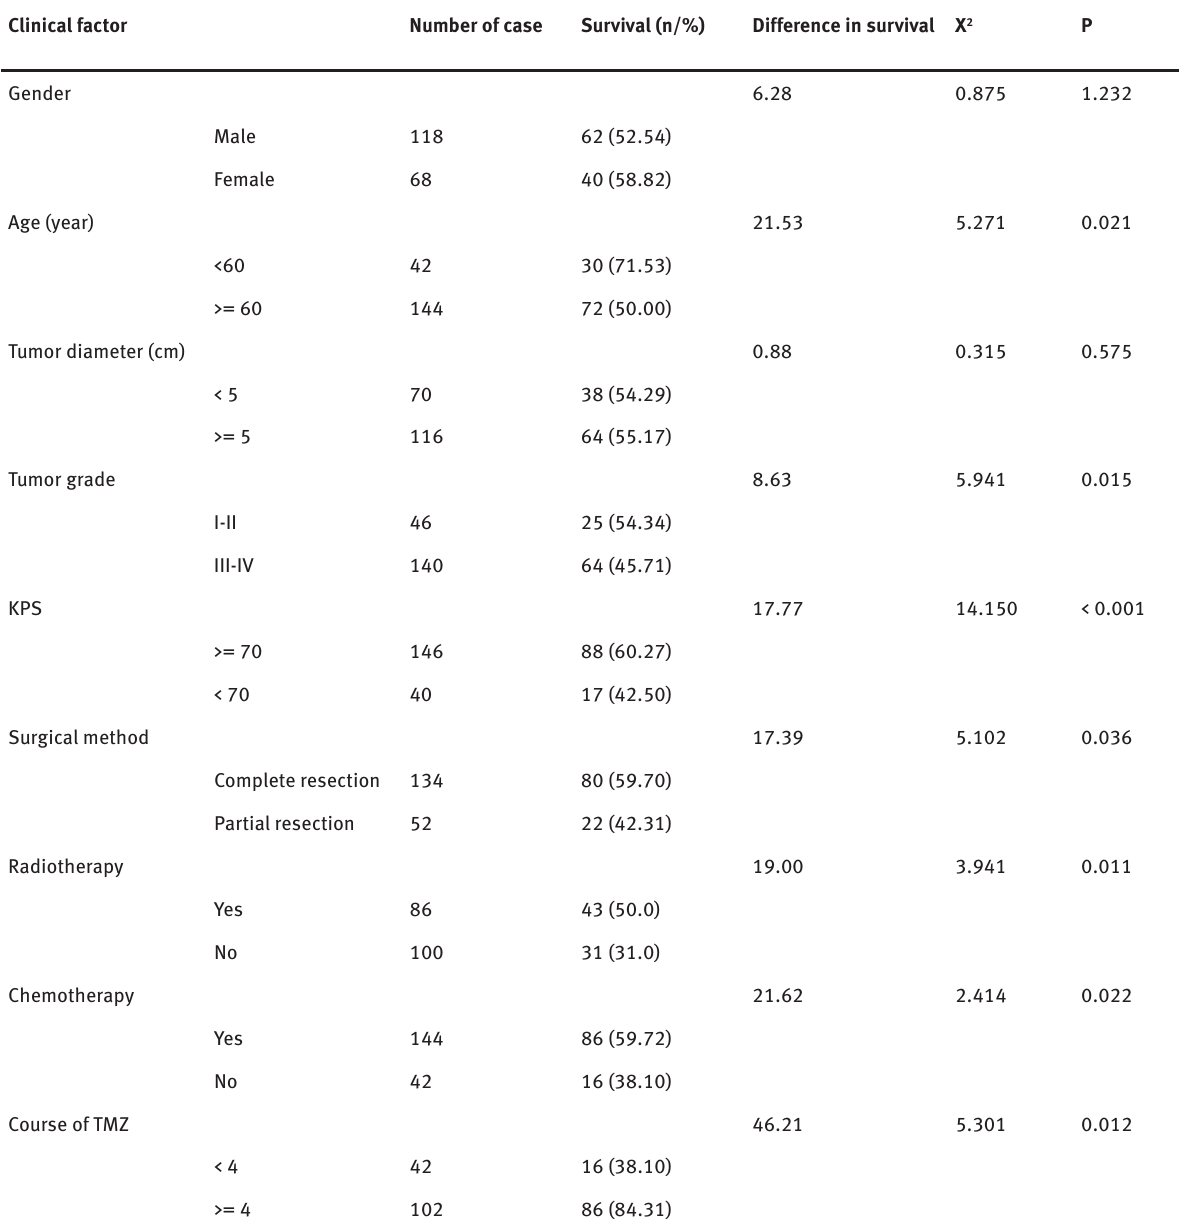
Table 1: Univariate analysis of prognostic factors in 186 glioma patients